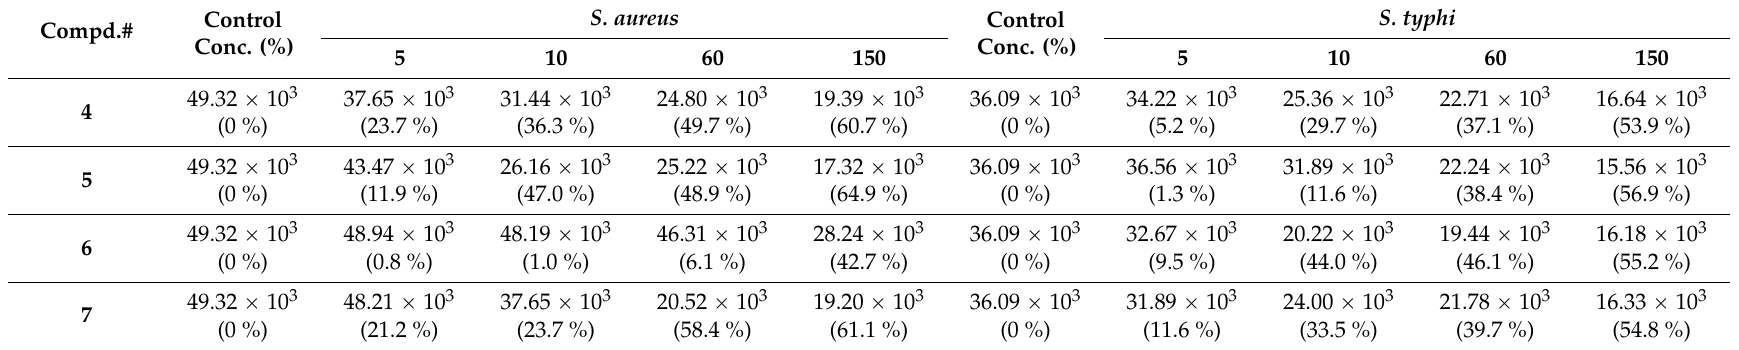
Table 4. Minimum Inhibitory Concentration ( µ g/mL) of the synthesized compounds 4 – 7 against Gram +ve (e.g., S. aureus and Gram -ve (e.g., S. typhi ) bacteria at different concentrations ( µ